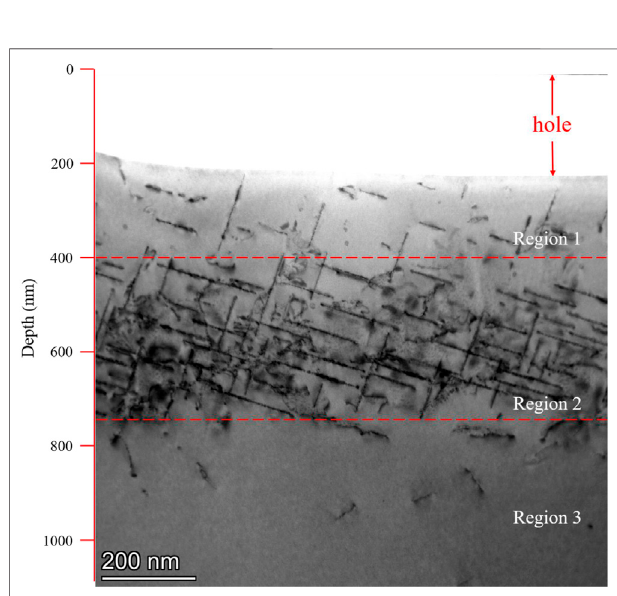
FIGURE8| STEMBFimages showingthespatialdistribution ofloopsof Fe-9Cr alloy near < 100 > zone axis.